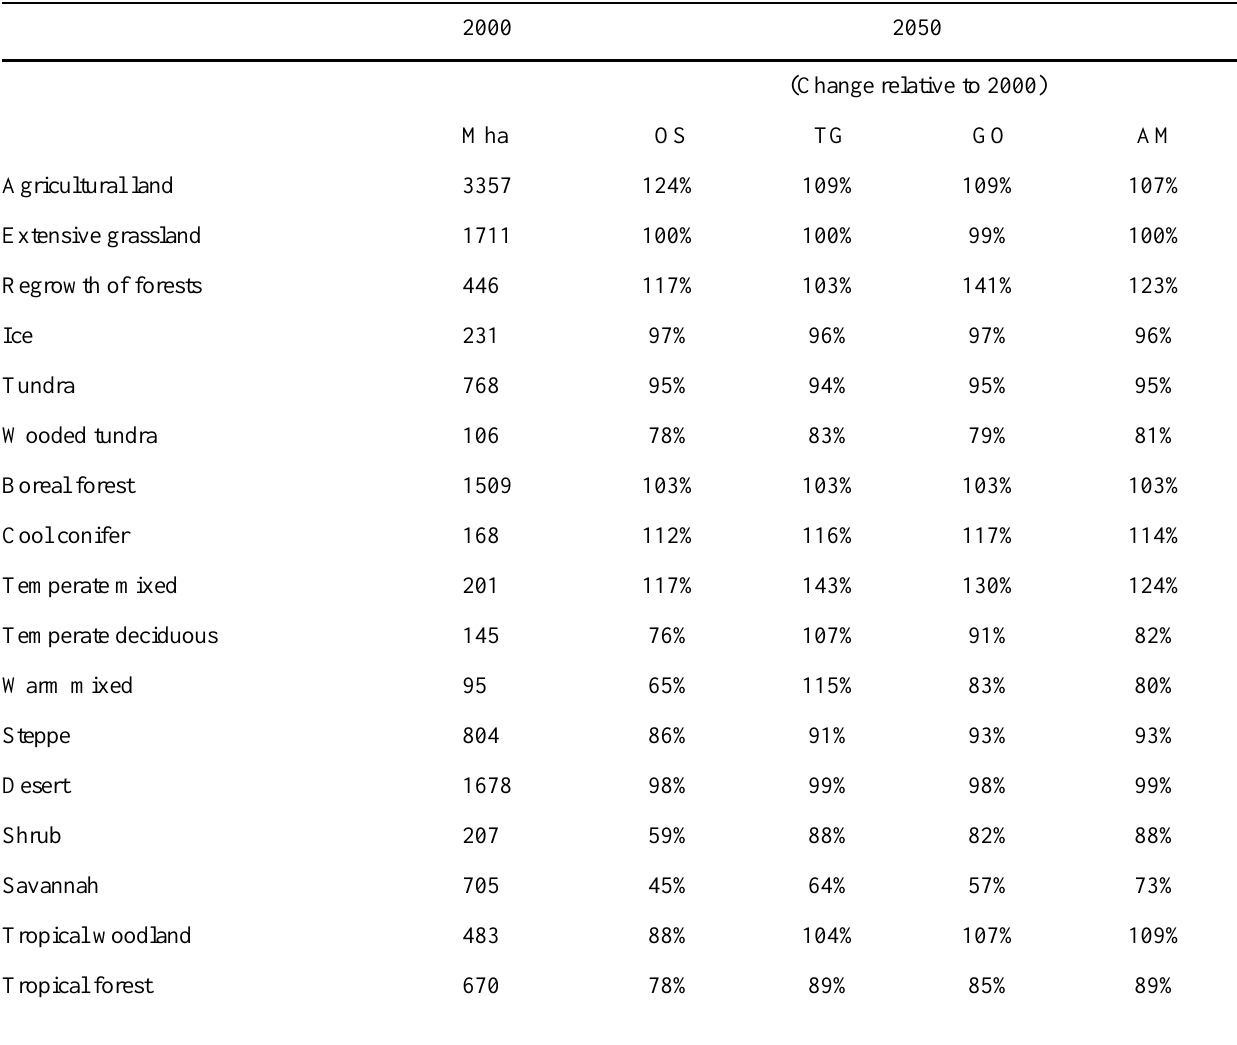
Table 2. Change in land cover in